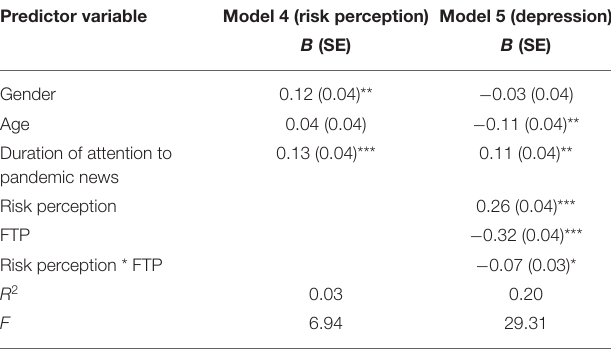
TABLE 4 | Testing the moderated mediation effect of FTP on depression. Predictor